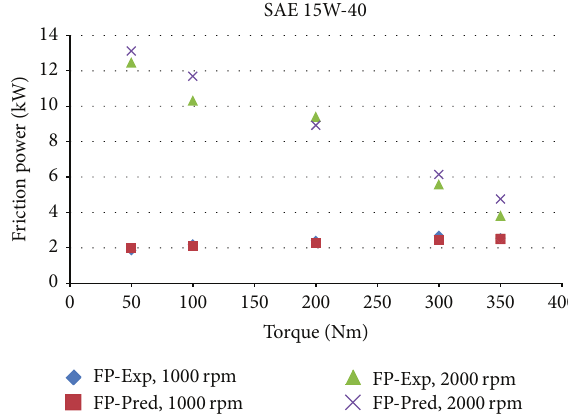
Figure 3: Experimental Friction Power (FP-Exp) and Predicted